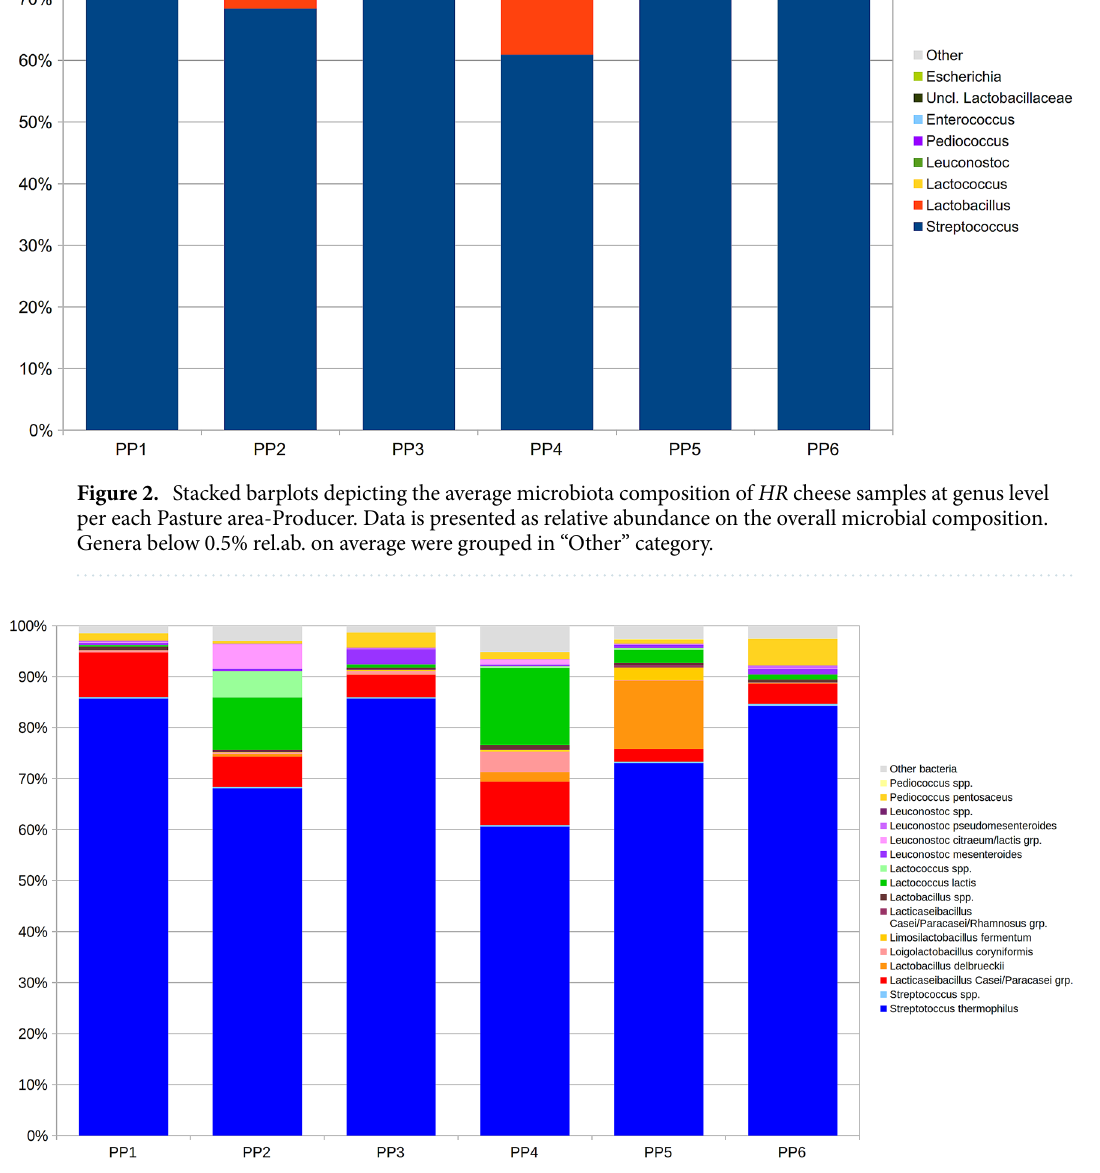
Figure 3. Stacked barplots depicting the average microbiota composition of HR cheese samples at species level per each Pasture area-Producer. Data is presented as relative abundance on the overall microbial composition. Only main species are represented. Low abundance species within each genus are grouped in the “spp.”